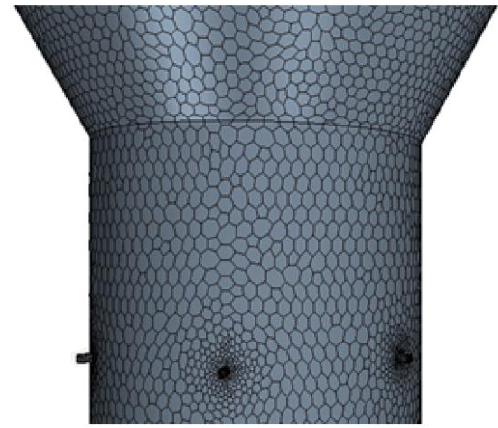
Figure 2 . Meshed gasifier geometry and customized mesh at air inlets. Figure 2. Meshed gasifier geometry and customized mesh at air